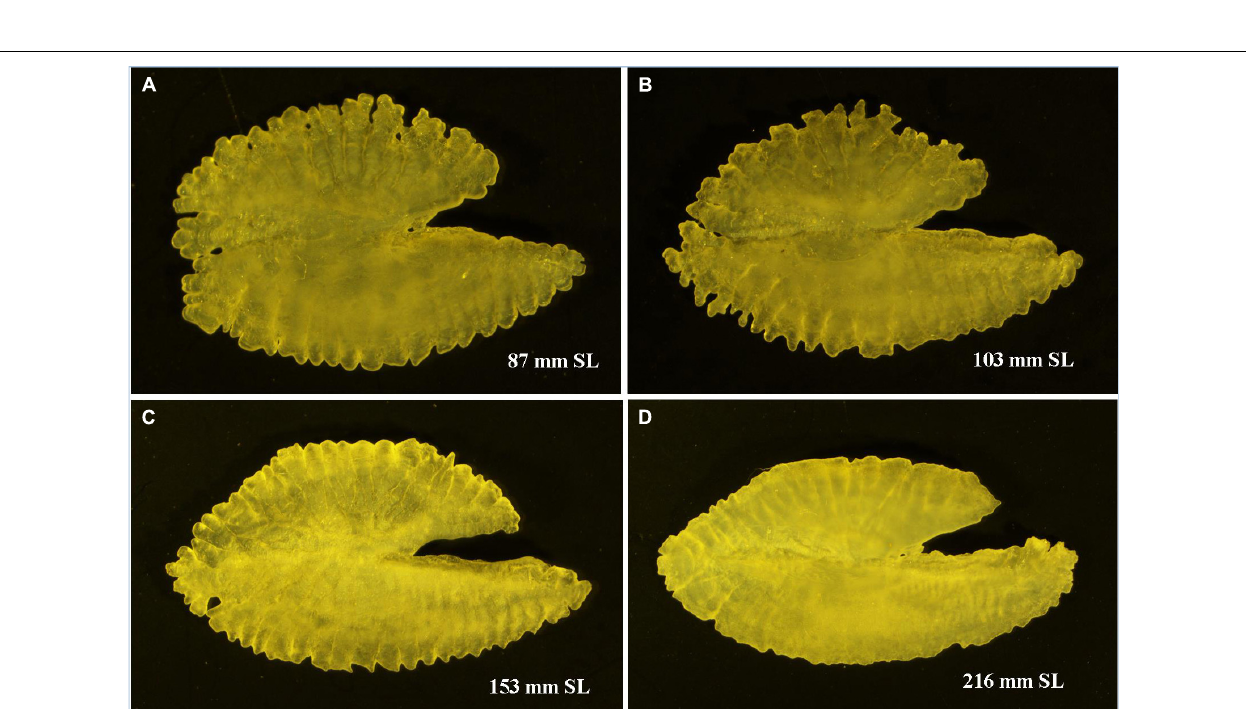
FIGURE 6 | Pampus chinensis . (A–C) Sagittal otolith of juvenile and subadult, and (D) adult specimens.